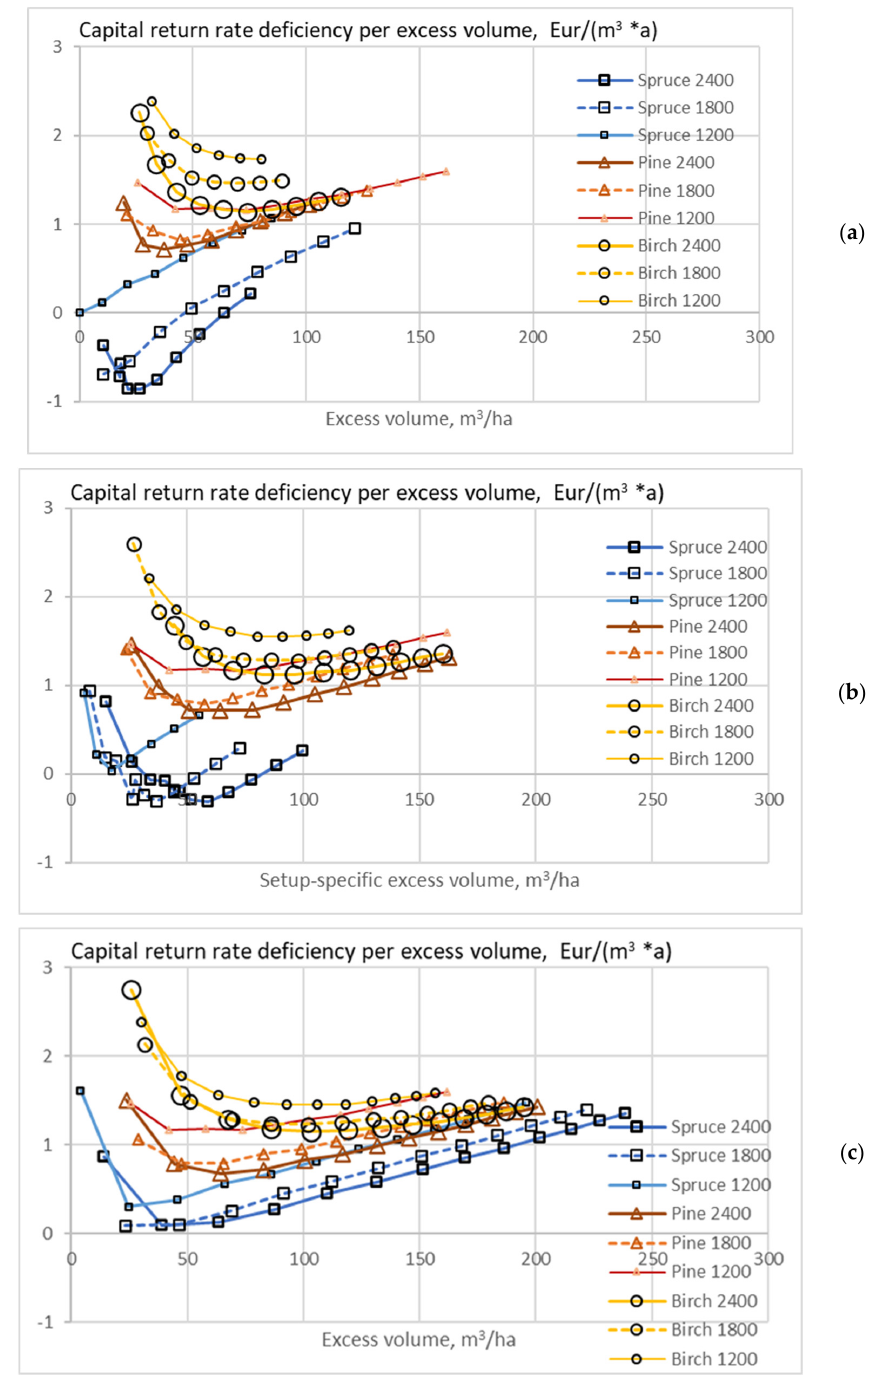
Figure 17. The expected value of capital return rate deficiency per excess volume unit on stands of different initial sapling densities, with inflated bare land value, as a function of excess volume, when the growth model is applied as early as applicable, without any thinning restriction ( a ), in good-quality trees of at least 238 mm of diameter only removed in thinning ( b ), and without any commercial thinning ( c ). The expected value of capital return rate and stand volume from spruce stands with 1200 saplings per hectare is taken as the common reference.